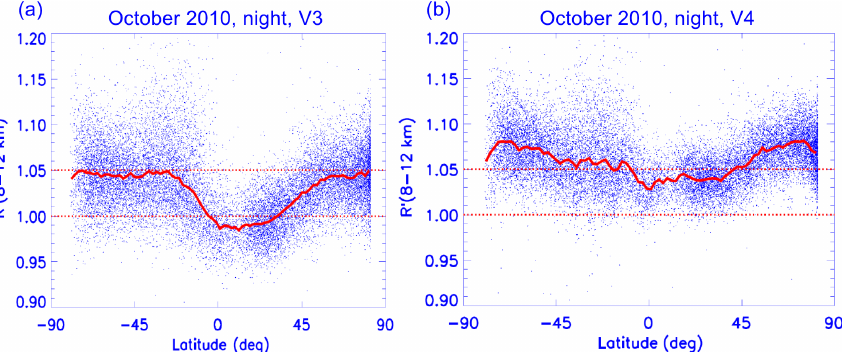
Figure 11. Clear-air attenuated scattering ratios at 8–12km as a function of latitude for the month of October 2010 for V3 (a) and V4 (b) . The thick red lines are median values calculated over 2 ◦ latitude bins.